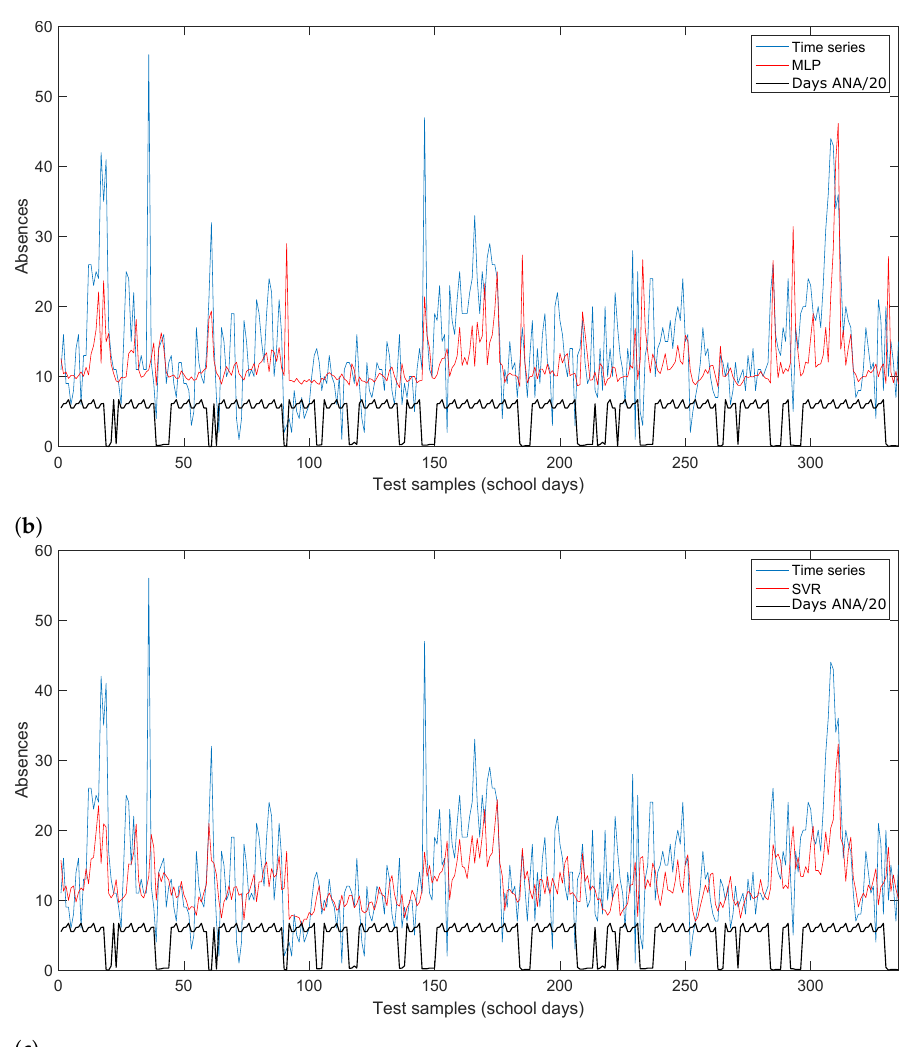
Figure 8. Performance of the different regressors considered in the prediction problem over the school absences problem, and similar days to the current one in the training set. ( a ) ELM; ( b ) MLP; ( c ) SVR. The black line represents the number of similar days in the training set normalized by 20, that is k